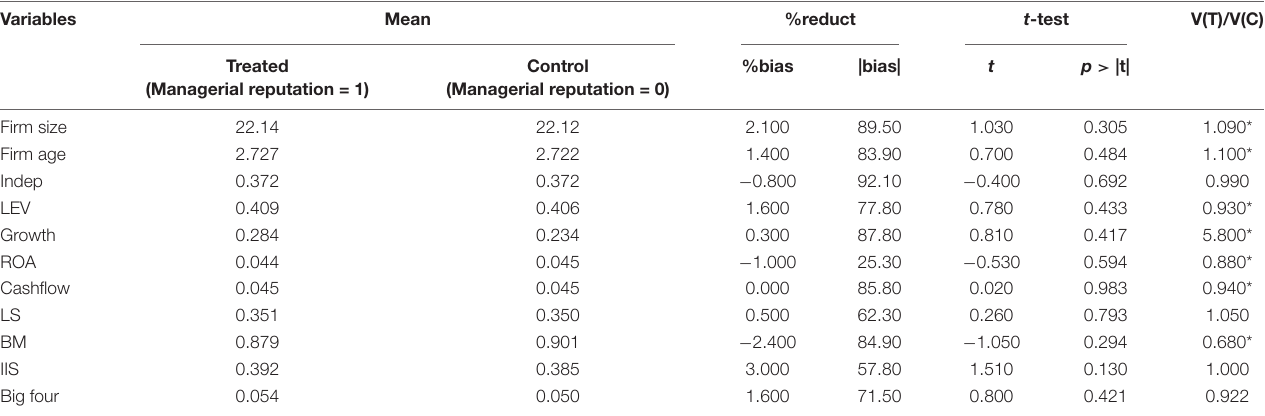
TABLE 8 | Equilibrium test results. Variables Mean %reduct t